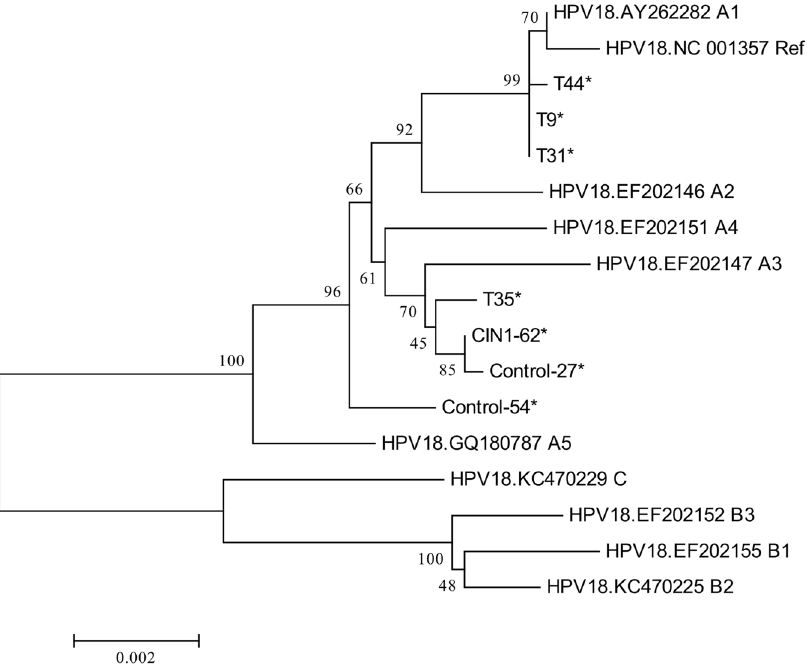
Figure 2. Phylogenetic tree based on whole-genome analyses of 7 HPV18-positive samples and 10 published representative HPV18 variant lineages and sublineages from the Genbank database. Phylogenetic analyses were conducted using the neighbor-joining algorithm implemented in MEGA software (version 6). Bootstrap analysis of 1000 replicates was performed on each tree to determine the confidence. Study sequences in the phylogenetic trees were marked with an